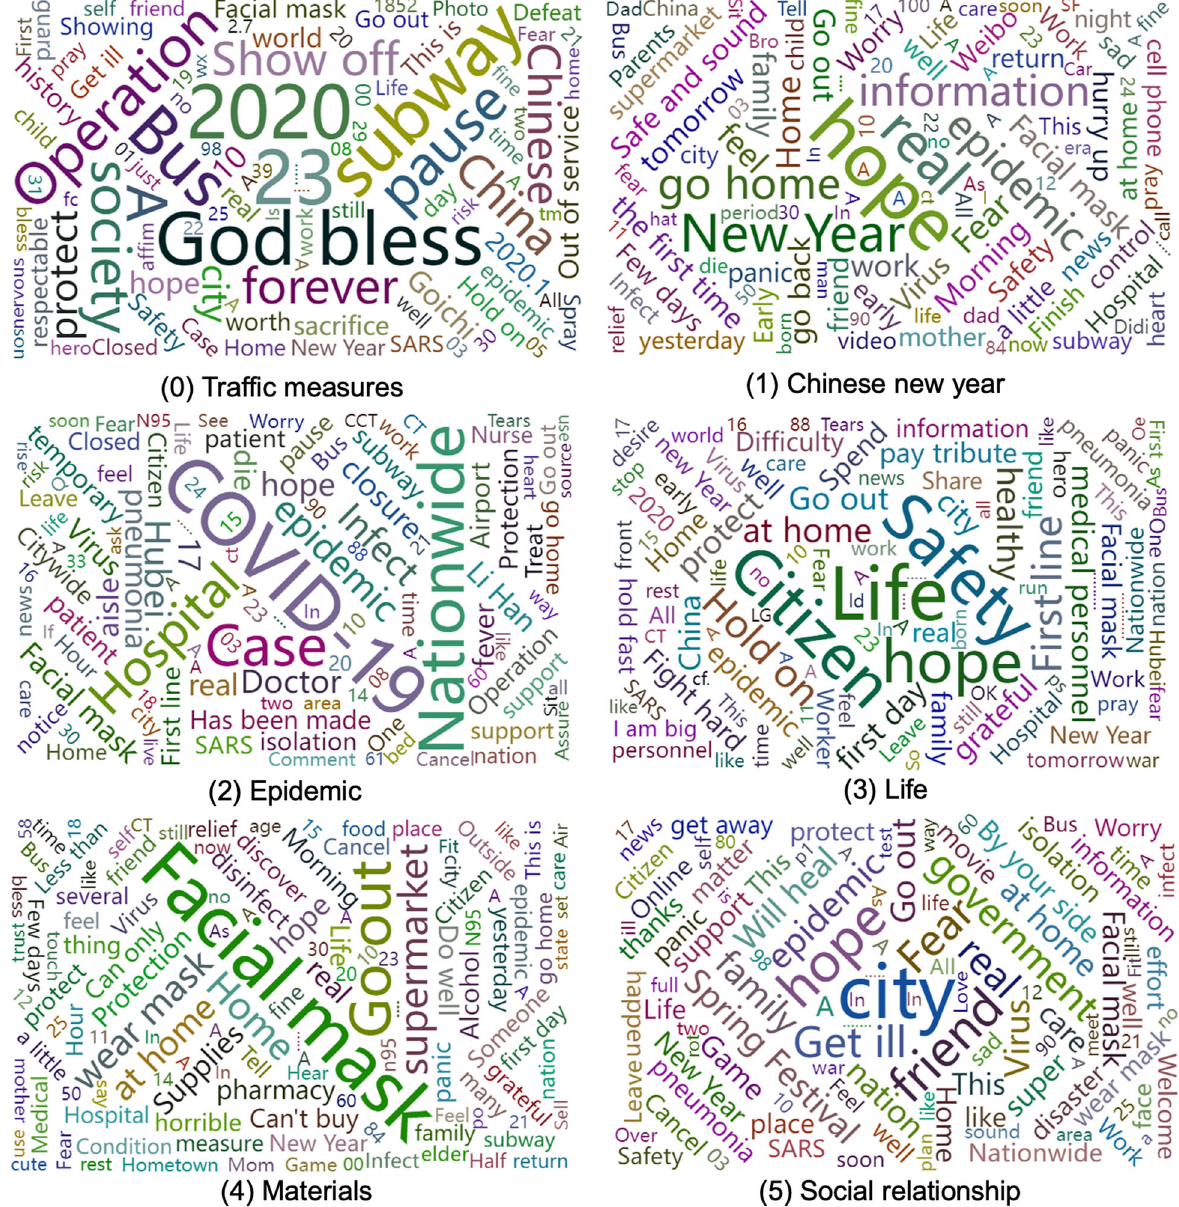
Fig. 6 Word cloud of Weibo posts in different categories. This picture compares word clouds of Weibo posts in different categories. These categories are determined by the LDA topic